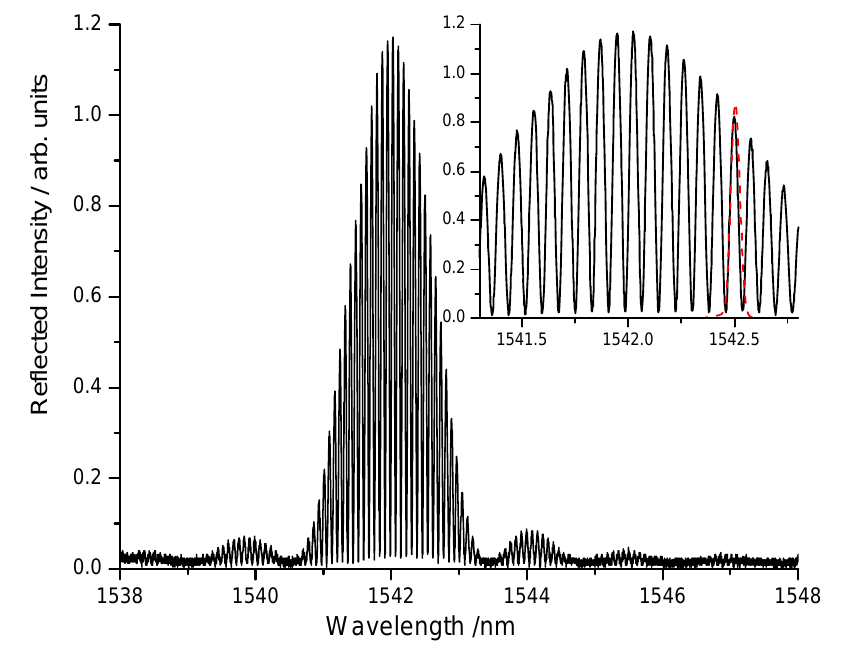
Figure 17. Reflection spectrum of an optical cavity made from two low reflectance FBGs spaced by 10 mm. The insert shows the laser emission spectrum as a red dashed